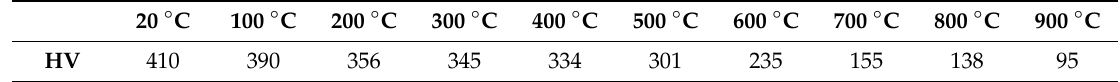
Table 3. The nominal value of hardness of Stellite 6 spray in hot